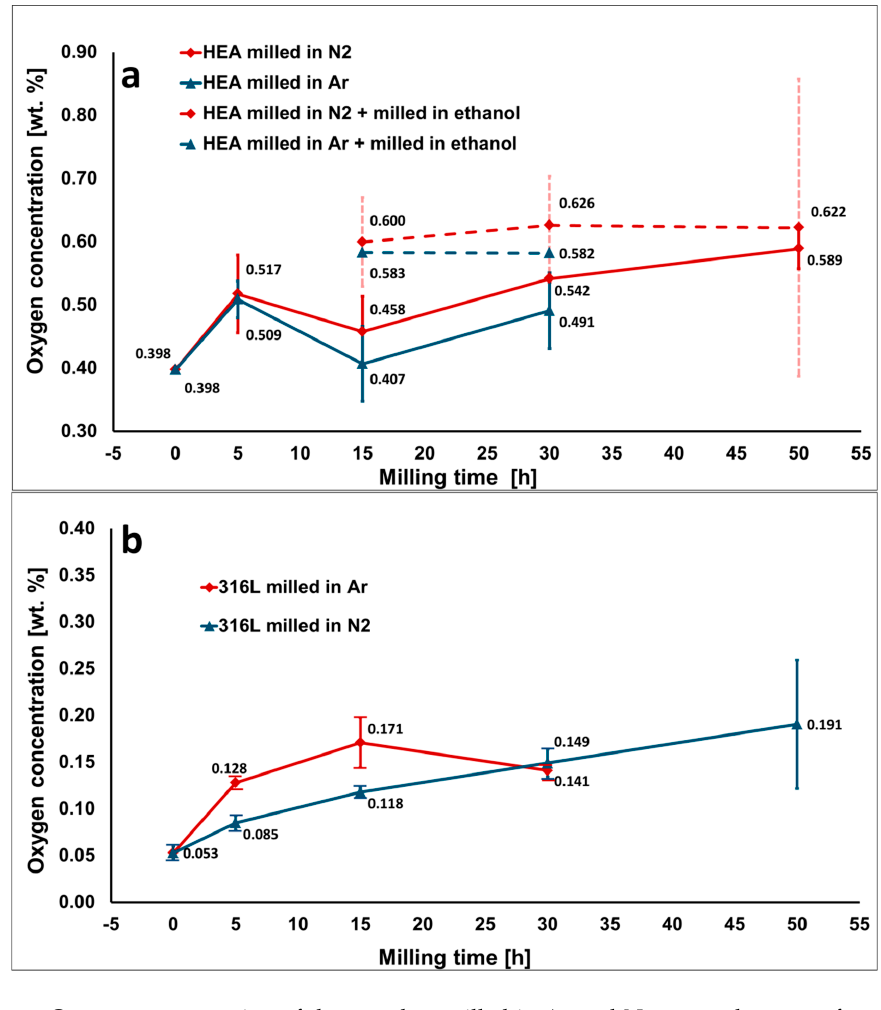
Figure 5. Oxygen concentration of the powders milled in Ar and N 2 atmosphere as a function of the milling time: ( a ) HEA powder, the dashed line represents powders additionally milled in PCA (ethanol) for 30 min; and ( b ) 316 L steel powder. The oxygen contamination gradually increases with milling time. Relatively high-oxygen concentration in unmilled HEA powder (0 h) is caused by initial oxidation of surfaces of elemental pure powders prior to milling.